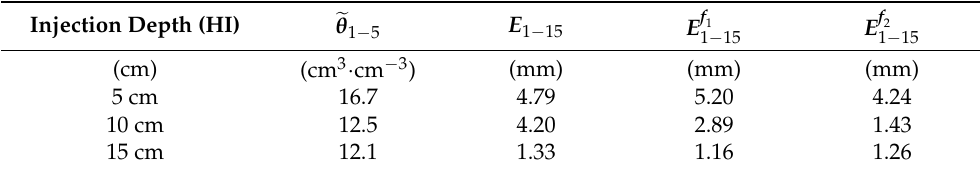
Table 2. Evaporation during initial 15 days for injection dose of 550 cm 3 ( E 1 − 15 ) calculated on the basis of the experiment with three pots, and on the basis of the functions f 1 ( DI , HI ) and f 2 ( (cid:101) θ ) (Equations (8) and